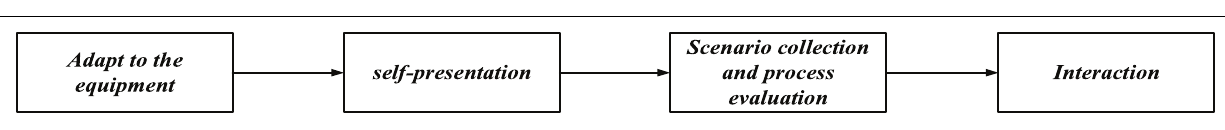
FIGURE 4 | Basic architecture of Internet of things (IoT).